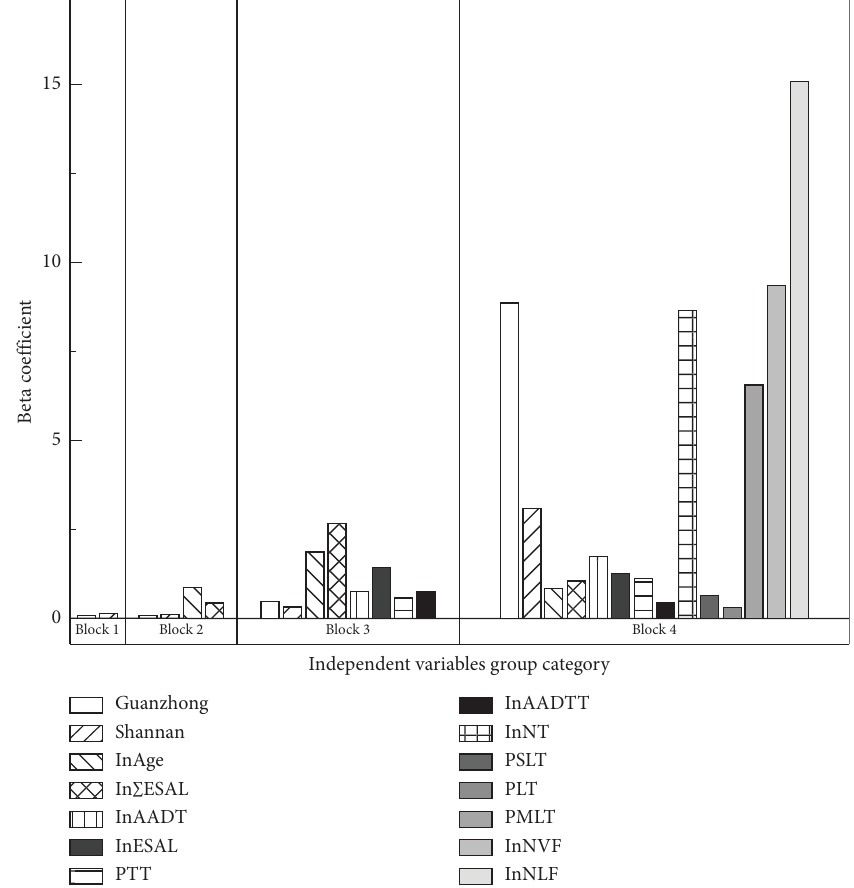
Figure 6: Beta coefcient of the independent